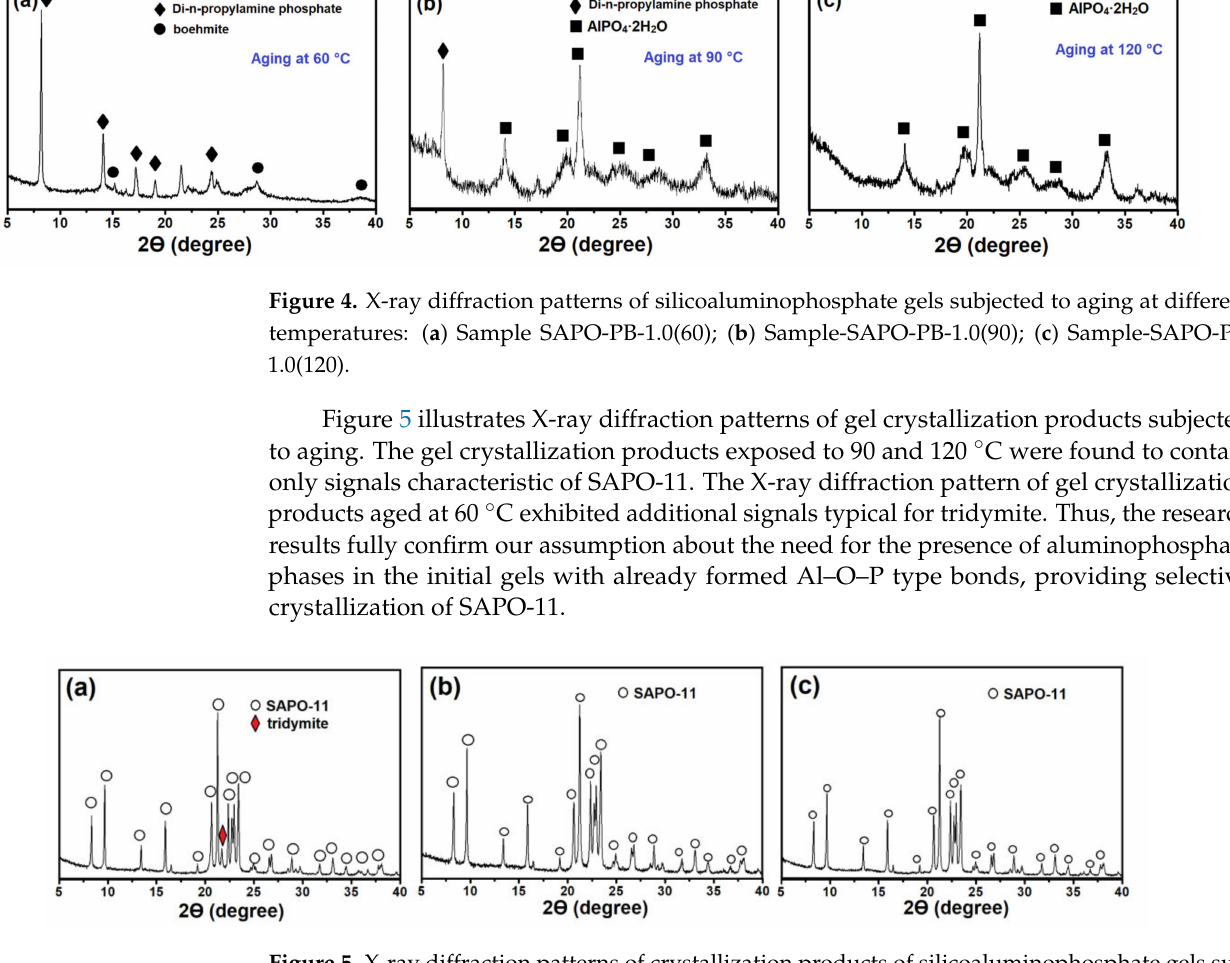
Figure 5. X-ray diffraction patterns of crystallization products of silicoaluminophosphate gels sub- jected to aging: ( a ) Sample SAPO-11-PB-1.0(60); ( b ) Sample-SAPO-11-PB-1.0(90); ( c ) Sample-SAPO-